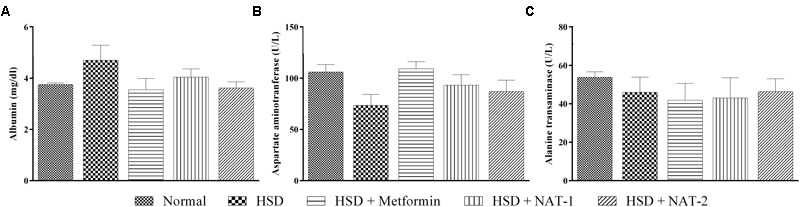
Effect of NAT-1 and NAT-2 on liver parameters in plasma of HSD-fed mice. (A) Albumin levels; (B) aspartate aminotransferase (AST) levels; (C) alanine transaminase (ALT) levels. All values are expressed as mean ± SEM (n = 5–6). No significant difference was observed.